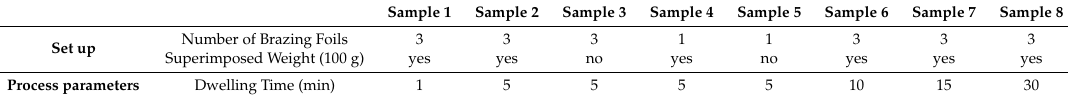
Figure 4. SEM micrograph of the cross-section of a Mo/Gemco/Glidcop joint manufactured by using three Gemco braze foils at 980 °C, 5 min, under flowing Ar and applying 0.02 MPa. Table 1. Brazing parameters for several sets of samples; joining temperature fixed at 980 °C, heating rate 1000 °C/h, Ar atmosphere (100 g superimposed weight corresponds to 0.02 MPa nominal pressure).